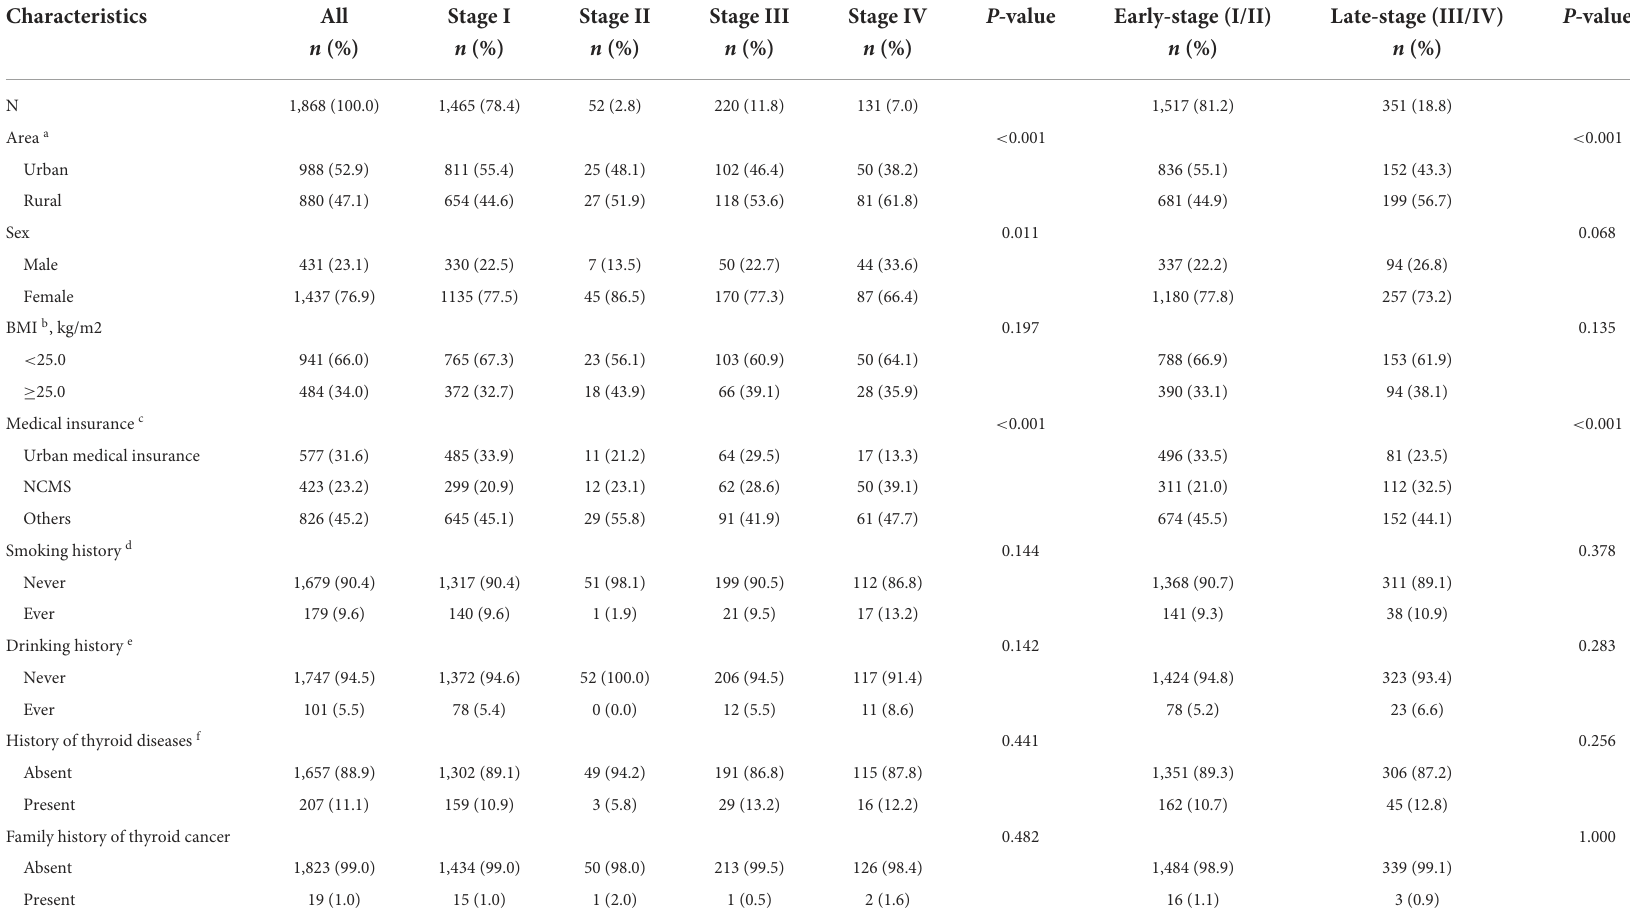
TABLE 1 Characteristics of DTC patients by stage